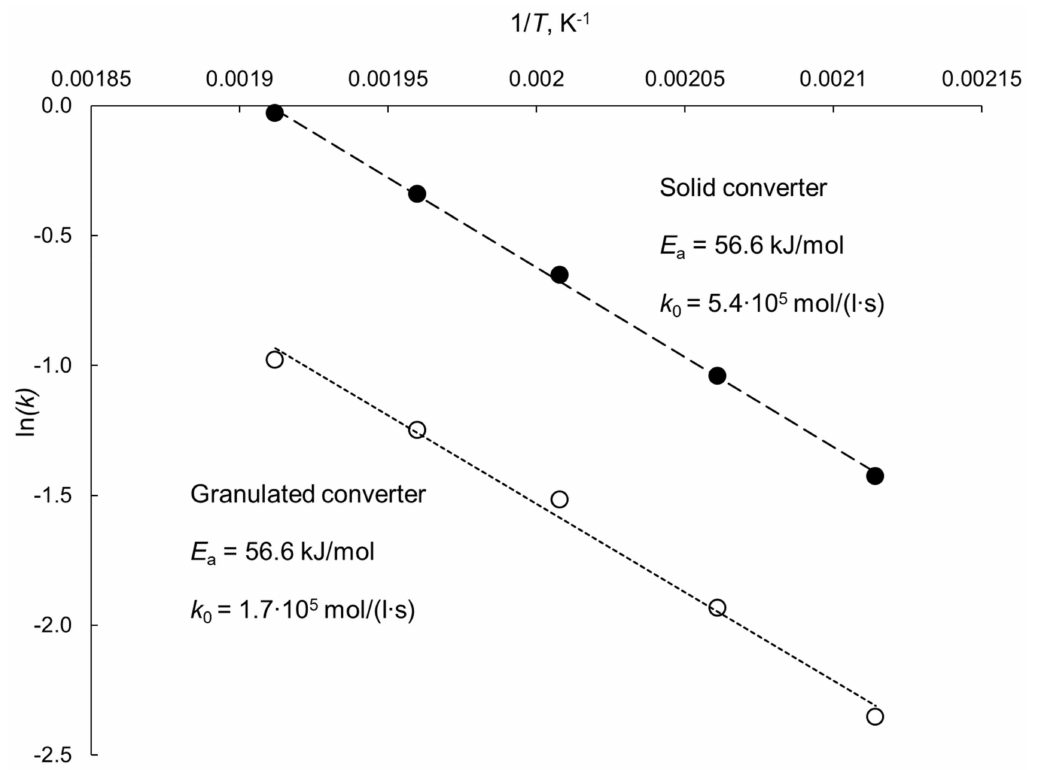
Figure 16. Arrhenius plots for hydrogenation of carbon monoxide contained in model mixture No. 2.